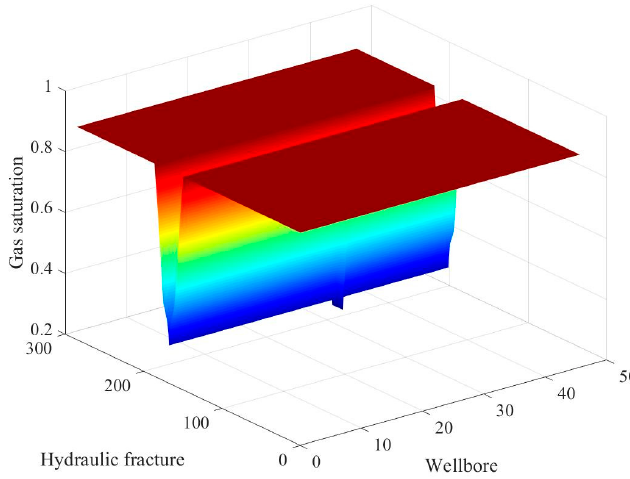
Figure 4. The distribution of gas saturation after 1 day .